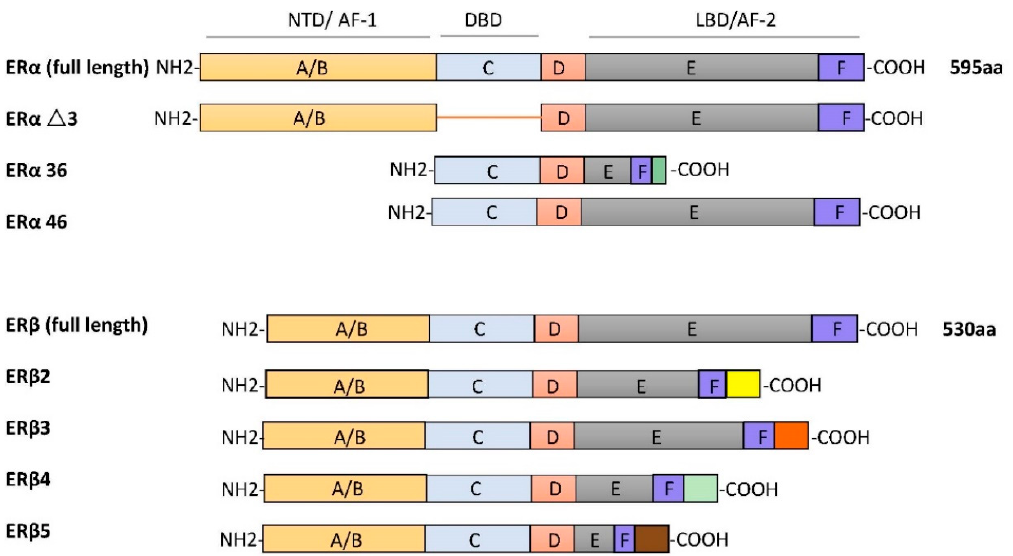
Figure 1. The schematic structures of estrogen receptor (ER) isoforms. Structural domains of ER α and ER β are labeled A–F. Different functional domains are highlighted as follows: N- terminal (NTD/AF-1) in orange, DNA binding domain (DBD, C domain) in blue, the hinge (D domain) in red, and ligand-dependent transactivation function 2 (LBD/AF-2) in gray/dark blue.